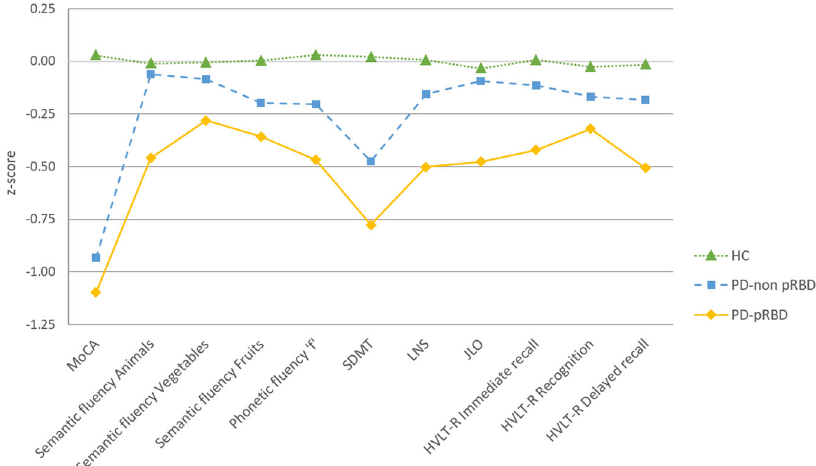
Fig. 1 Neuropsychological performance. Tasks are indicated in the x axis. Group means in each task are presented as z- scores, as indicate in y axis. Data are presented as z -scores adjusted by age, sex and education. Lower z -scores indicate worse performance. Descriptive statistics of raw scores, as mean (SD), are available in Supplementary Table 1. Healthy controls in green, PD-non pRBD in blue, PD-pRBD in yellow. Healthy controls represented by fi lled triangles and a dotted line, PD-non pRBD by fi lled squares and a dashed line and PD-pRBD by fi lled rhombuses and a continuous line. MoCA